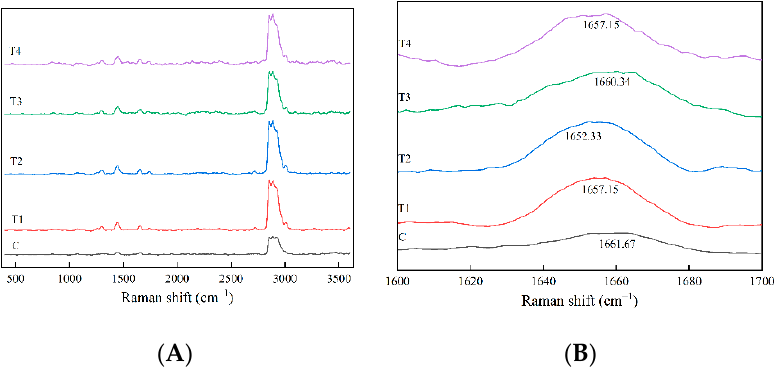
Figure 5. Raman spectra in the regions of 400–3600 cm − 1 ( A ) and 1600–1700 cm − 1 ( B ) of proteins in the cooked pork batters prepared with various amounts of ORP.